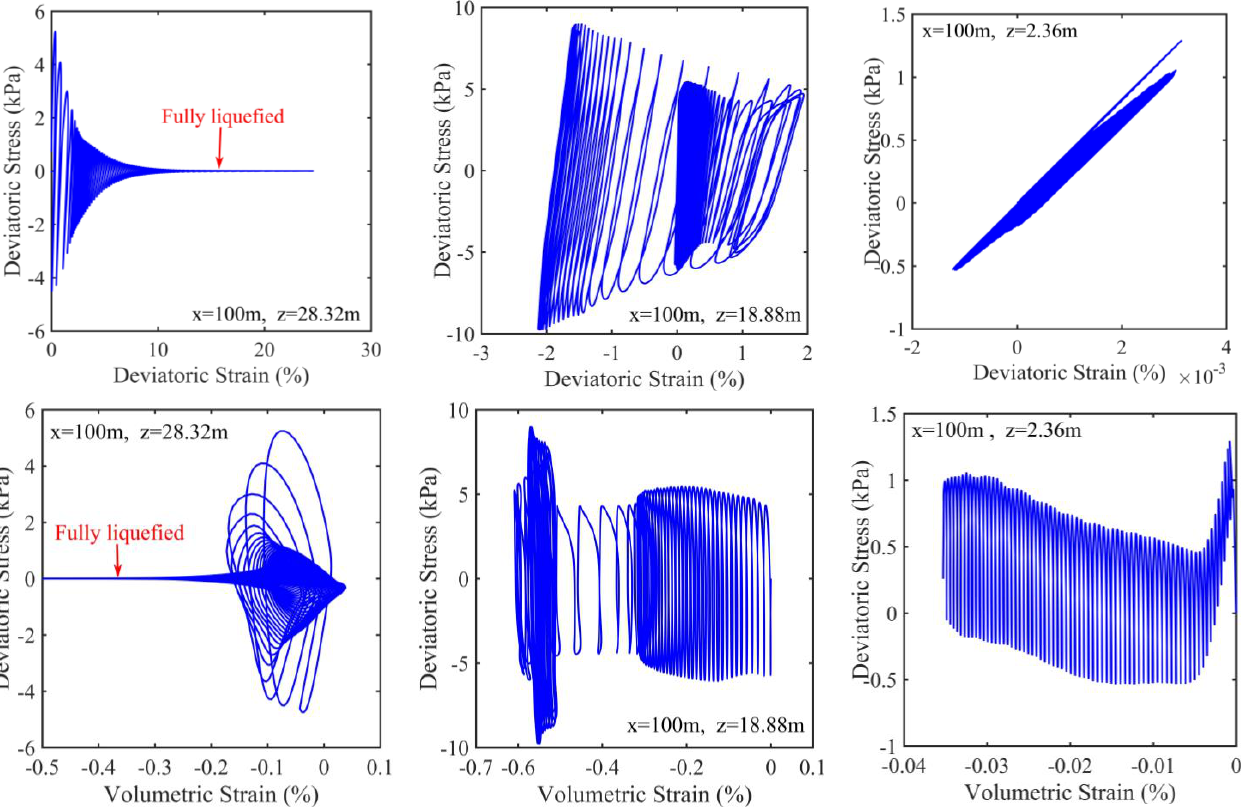
Figure 7. Stress – strain relationship at three typical buried depths on x = 100